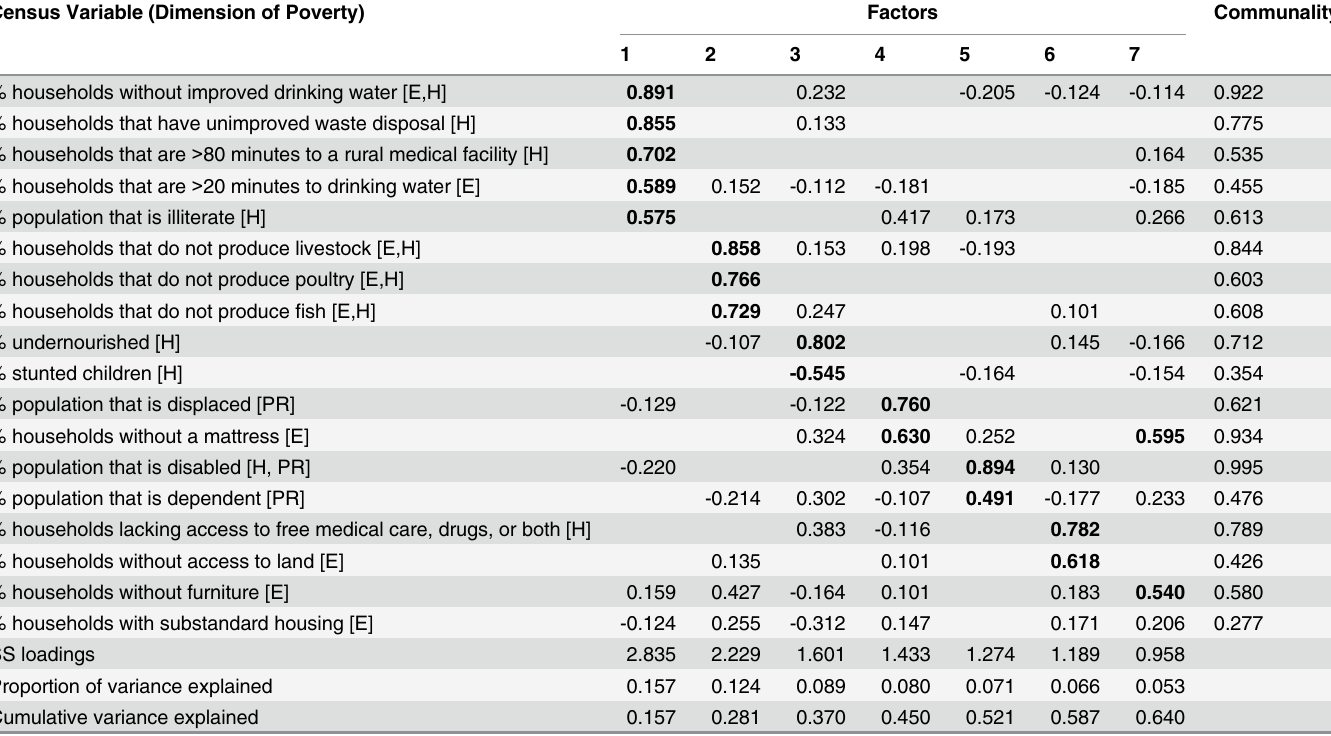
Table 2. Factors, factor loadings, and communalities for 18 social vulnerability attributes across Liberian districts as derived from exploratory fac- tor analysis. Census Variable (Dimension of Poverty) Factors